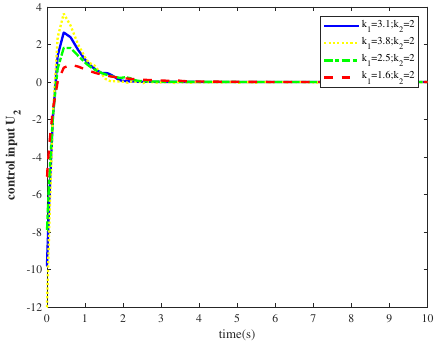
Figure 9. U 2 of different k 1 and k 2 .